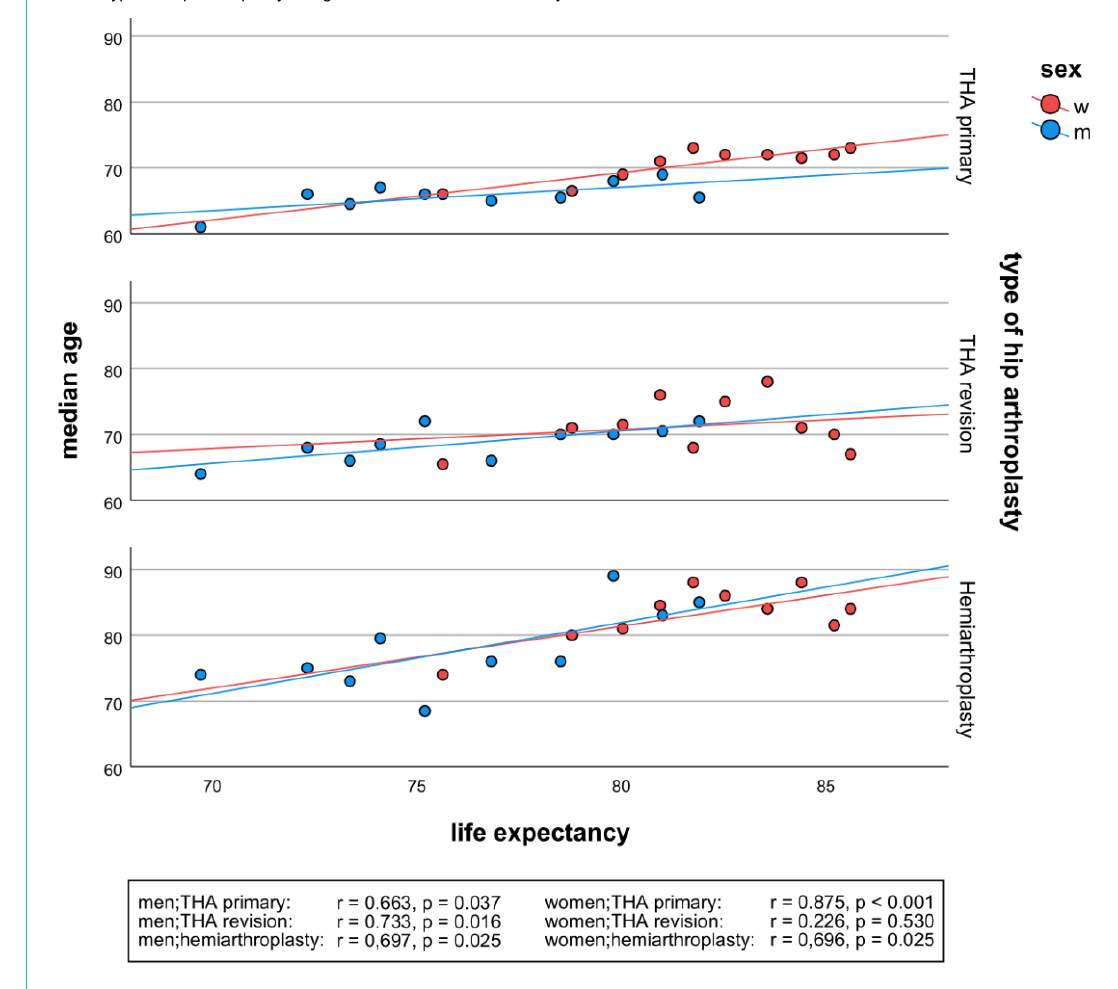
Figure 3: Linear regression relation between life expectancy of Swiss population & median age of patients included in the study according to different types of hip arthroplasty and gender from 1969 to 2019 at 5-year